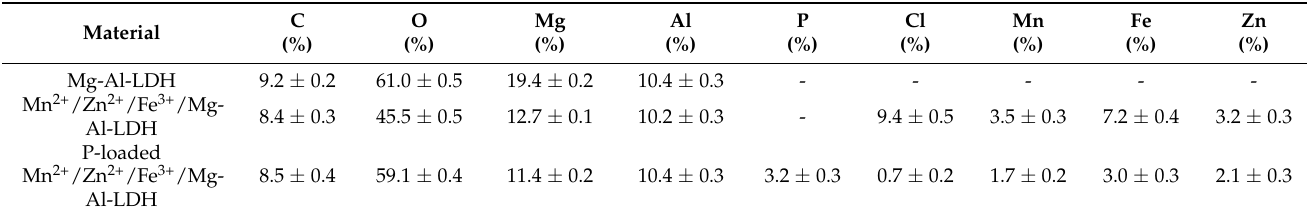
Table 1. Semiquantitative elemental composition of LDH